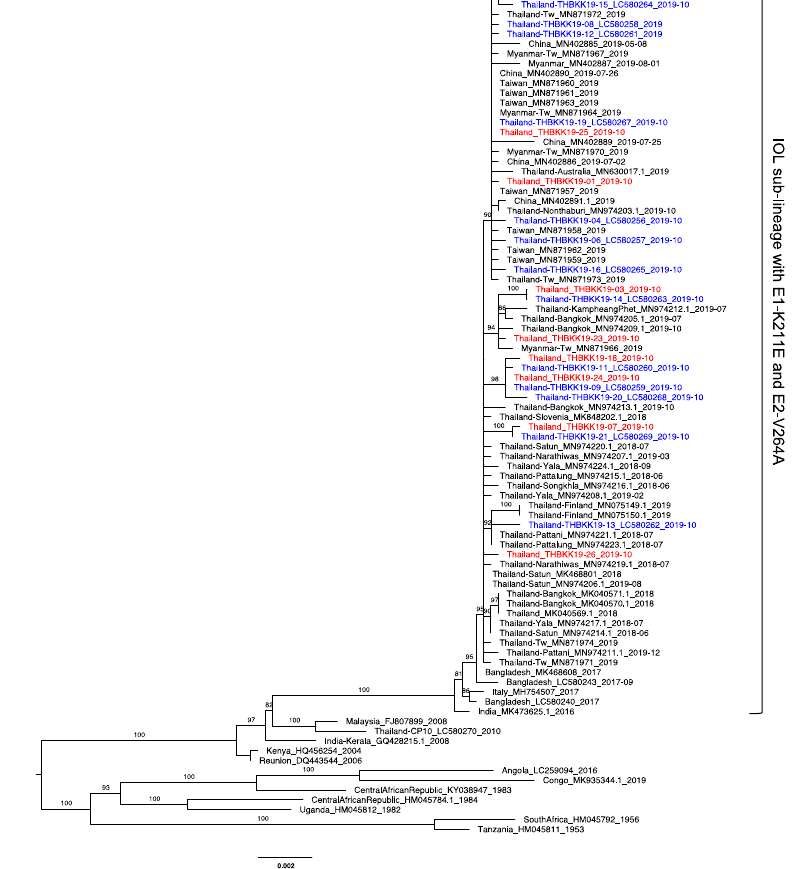
Figure 2. Phylogenetic tree based on the structural polyprotein region (3747 bp) of East/Central/South African chikungunya virus. A maximum likelihood tree was constructed under TN+F+G4 and 1000 ultrafast bootstrap replicates. The bootstrap values (%) over 80 are labeled on each branch. The 9 Bangkok CHIKVs sequenced in the present study and 14 sequenced in the previous study are indicated in red and blue, respectively. Bangkok CHIKVs were clustered with recent CHIKVs reported in Thailand and nearby areas. The IOL sub-lineage with E1-K211E and E2-V264A is indicated to the right.